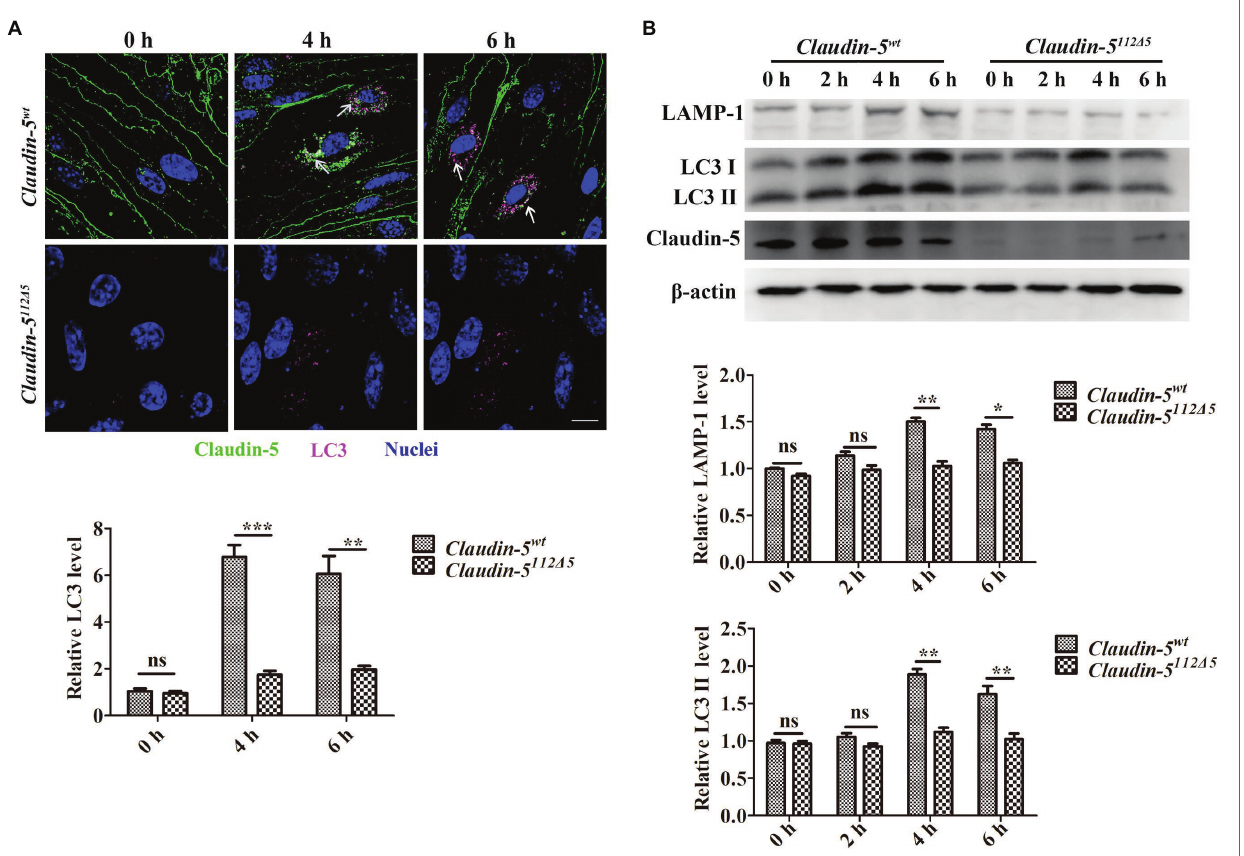
FIGURE 1 | The specificity of the involvement of Claudin-5 in autophagy under hypoxia induction. (A) Confocal microscopy images of Claudin-5 (green) and LC3 (purple). Colocalization of Claudin-5 with LC3 (white arrow) and quantitative analysis of LC3 levels by Image-Pro Plus. Mean ± SD, n = 3 independent experiments per group. Scale bar, 10 μ m. (B) Western blot analysis of the autophagy markers LC3 and LAMP-1. Mean ± SD, n = 3 independent experiments per group. * p < 0.05 ** p < 0.01 and *** p <